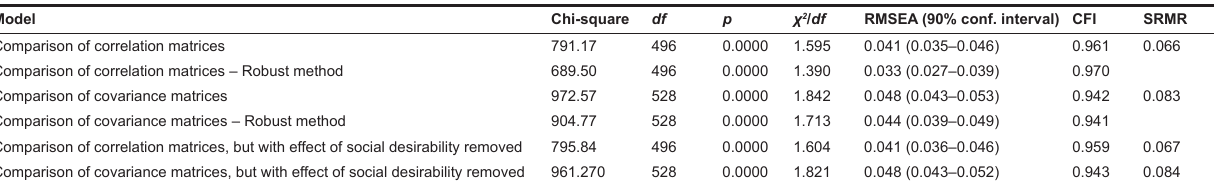
Table 3 Analysis of covariance structures goodness-of-fit statistics for the Black and White